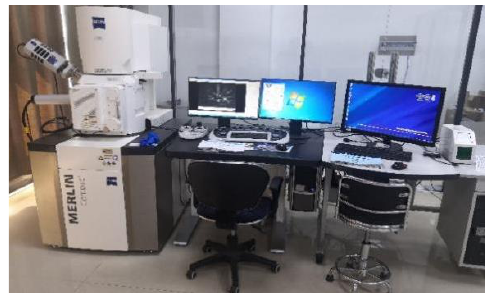
Figure 3. SEM device.